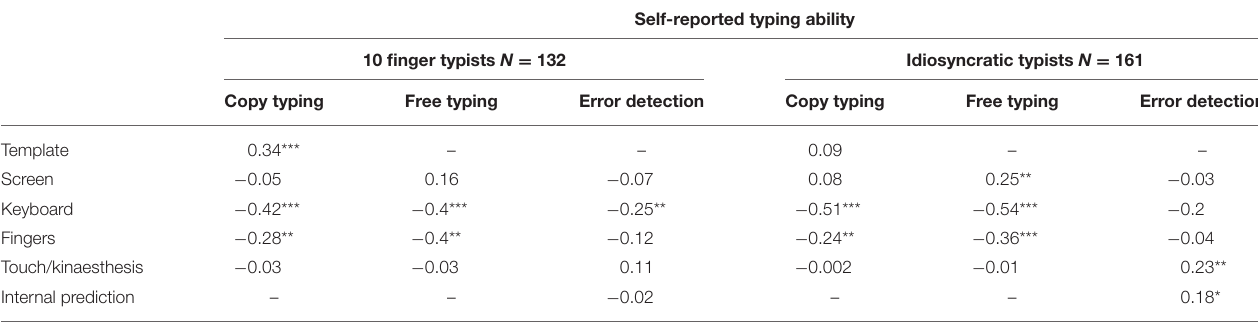
TABLE 4 | Correlations between attention to/use of different sources of information and self-reported typing ability separately for 10 finger typists and idiosyncratic